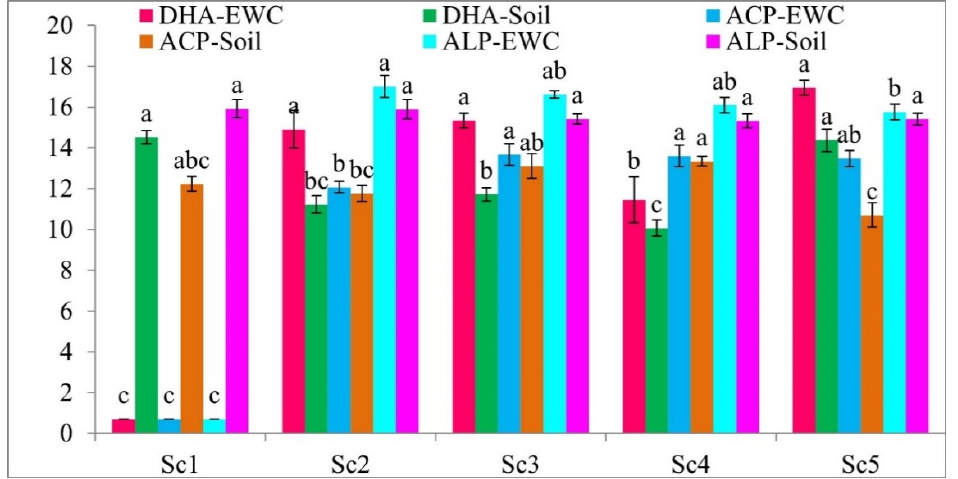
Figure 3. Dehydrogenase ( μ g TPF g − 1 soil h − 1 ), acid and alkaline phosphatase ( μ g p-NP g − 1 soil h − 1 ) activity in soil and earthworm cast (EWC) as influenced by different CSA-based crop management scenarios (data transformed through square-root method). Pars with a similar lowercase letter (s) are not significantly different at 0.05 level of probability using Tukey’s HSD test. Letters apply only within each parameter. (for a detailed description of scenarios refer to Table 1).